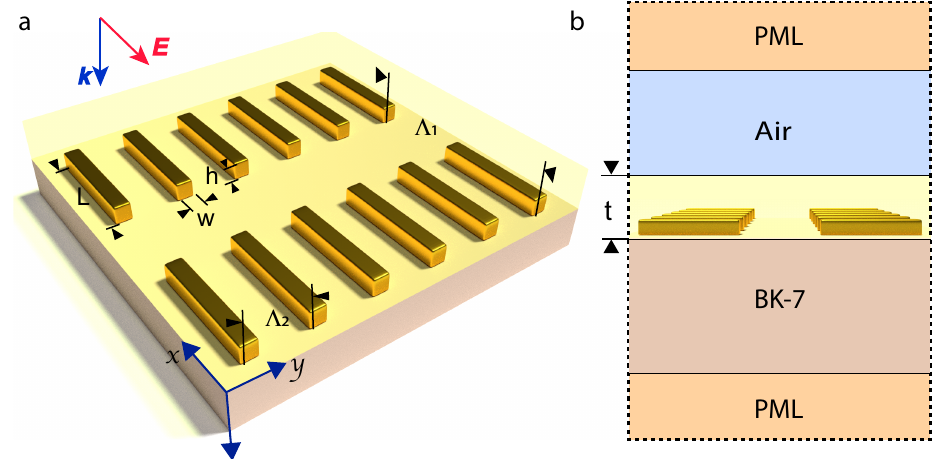
Figure 2. ( a ) 3D schematics of the gold metasurface modeled in COMSOL Multiphysics software. The width and height of gold nanoparallelepipeds (NPs) in the array are of w = h = 20 nm, while the length is varied. The longitudinal and transverse lattice constants are defined as Λ 1 and Λ 2